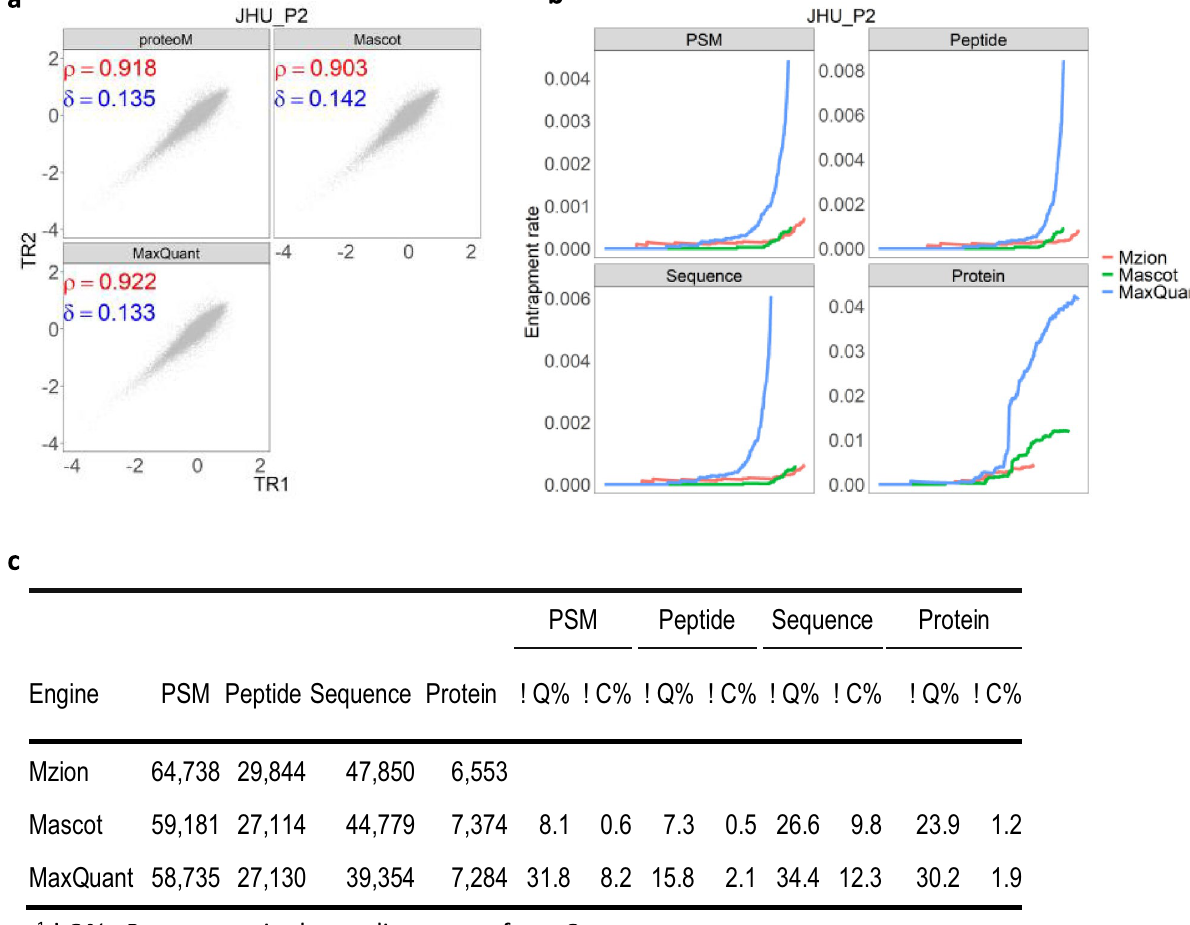
Figure 3. Performance of Mzion on the phosphopeptide dataset JHU_P2. ( a ) Pearson correlation (ρ) and Manhattan distance (δ) of log2FC. ( b ) Entrapments of PSMs, peptides, sequences and proteins by database Arabidopsis thaliana . ( c ) Summary in PSM and peptide